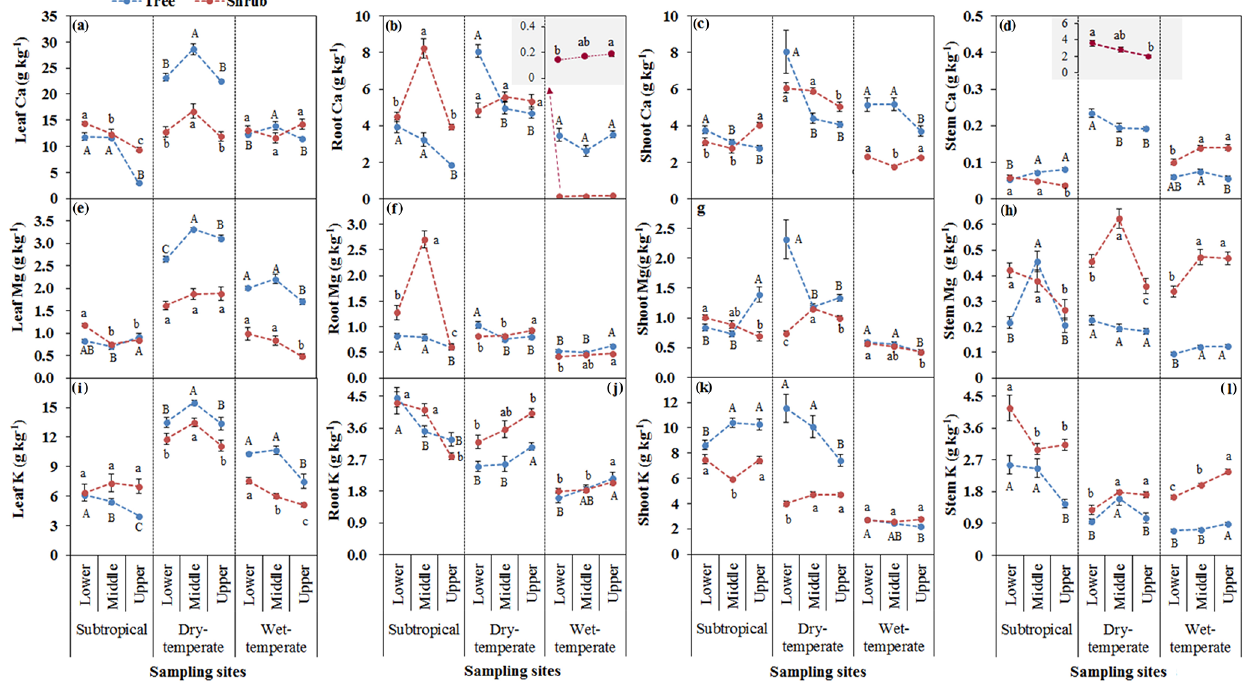
Figure 3. Base cation concentrations of Ca (a, b, c, d) , Mg (e, f, g, h) and K (i, j, k, l) in plant tissues of leaf, root, shoot, and stem sapwood at lower and middle elevations as well as at the upper limit of trees and shrubs for each of the three sites. Different letters indicate significant differences among three elevations within tree and shrub lines for each site.